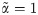
Resilience to drop-off, computed analytically (solid lines) and numerically (dots) for L = 1 and α˜=1.Red: β˜=0.1, blue: β˜=0.01, and green: β˜=0.001. For these simulations, the transient time was 109 iterations, followed by an integration time of 109 iterations.